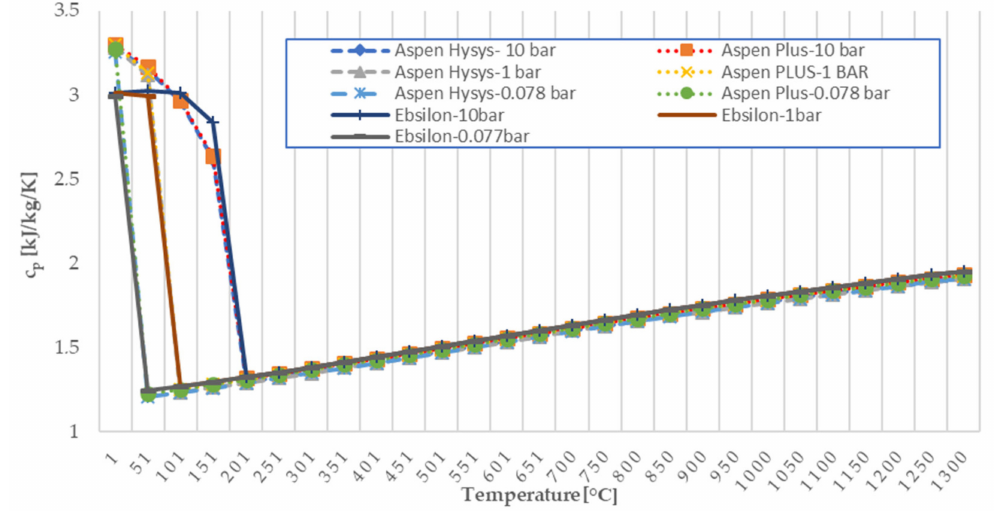
Figure 14. Distribution of heat capacity at constant volume per temperature after WCC at different pressure in Aspen Hysys, Aspen Plus and